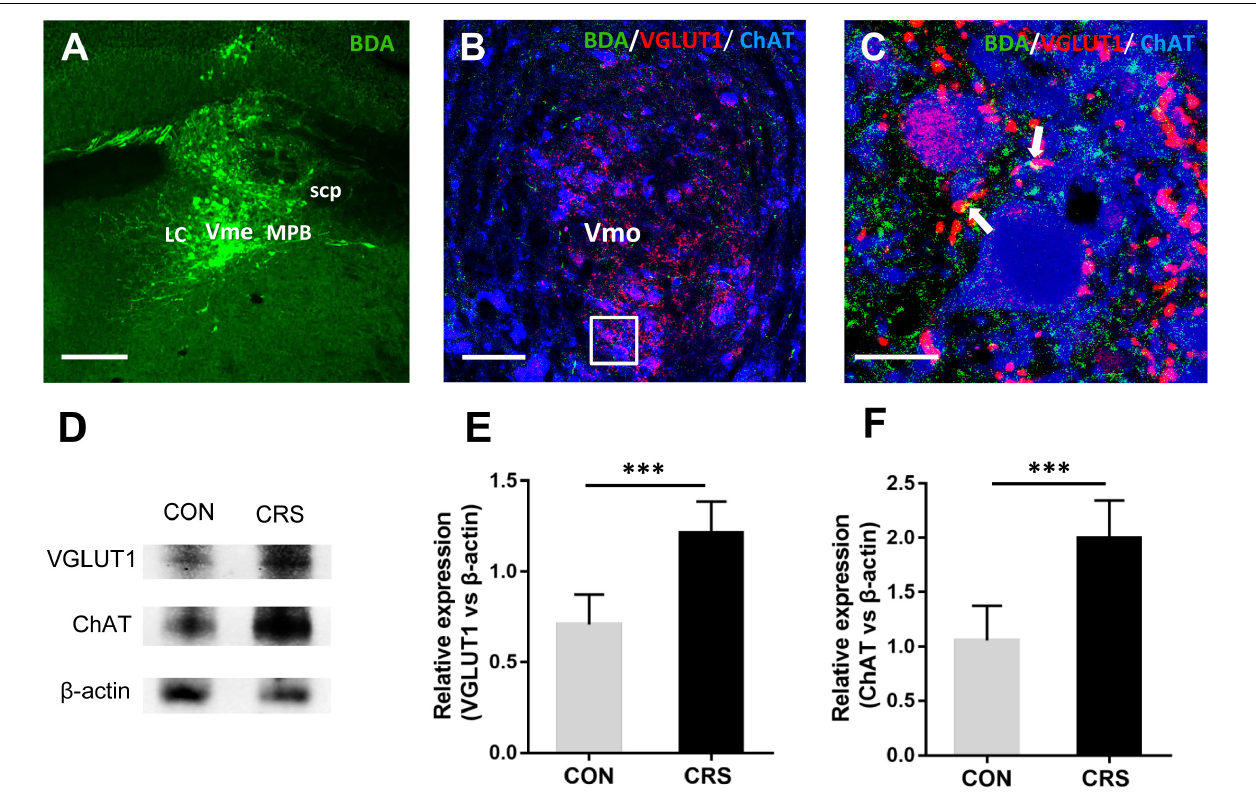
FIGURE 3 | Neuronal tract tracing results of glutamatergic projections from the Vme to the Vmo and the expression of VGLUT1 and ChAT in the Vmo. (A) The injection site verified in the Vme. (B) Immunofluorescent triple labeling for BDA (green), VGLUT1 (red), and ChAT (blue) in the Vmo in mice injected with BDA into the Vme. The framed area in panel (B) is magnified in panel (C) . White arrows indicate axonal buttons labeled with both VGLUT1 (red) and BDA (green), which were merged (yellow) and in close apposition to ChAT-positive Vmo soma (blue). Scale bars: 200 µ m in panel (A) ; 100 µ m in panel (B) ; 20 µ m in panel (C) . (D) Western blotting results of VGLUT1 and ChAT expression in the Vme of mice ( n = 5/group). Statistical analysis revealed that VGLUT1 (E) and ChAT (F) expression in the CRS group was significantly higher than that in the CON group. ∗∗∗ P <